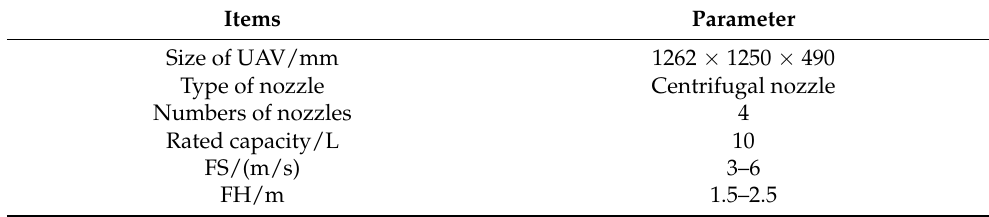
Table 2. Main parameters of P20